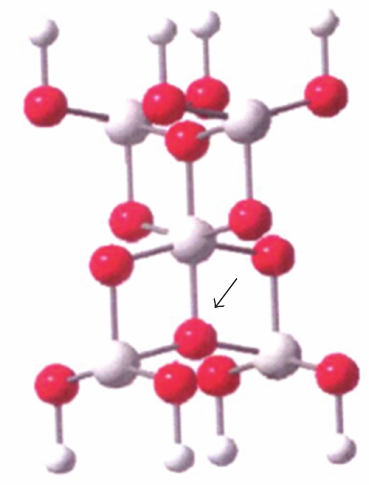
Figure 2: Model of the cluster (Ti 5 O 14 H 8 ) [the position of the replaced oxygen is shown by an